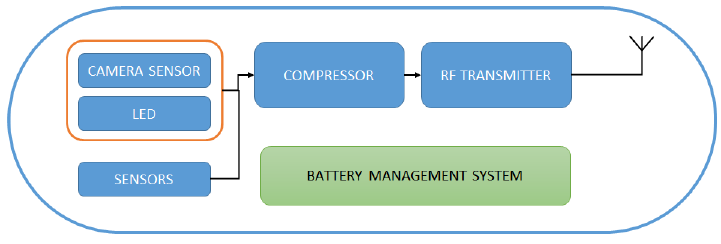
Figure 1. Simple block diagram of an entire endoscopic capsule